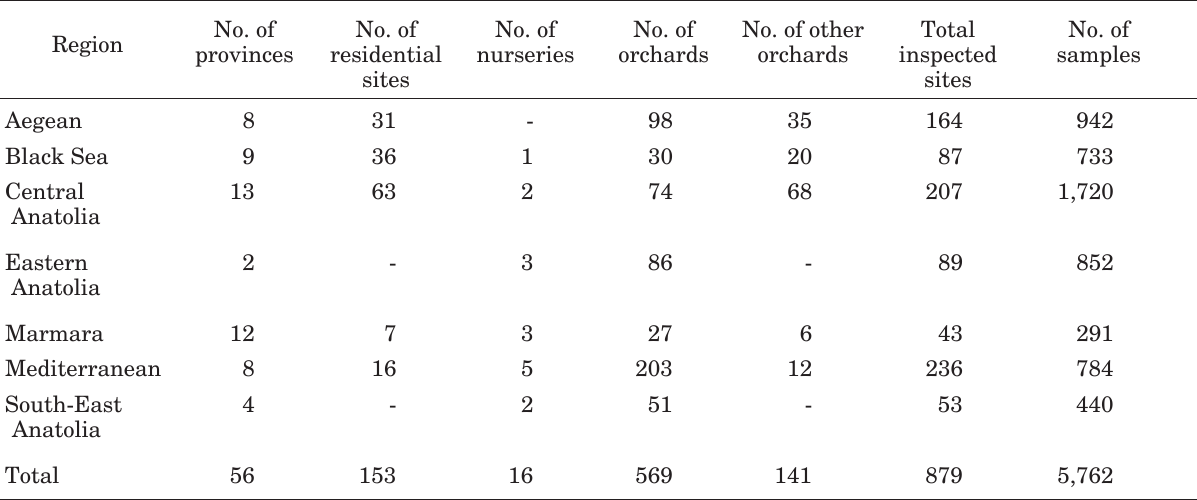
Table 1. Sites inspected in the surveyed areas.